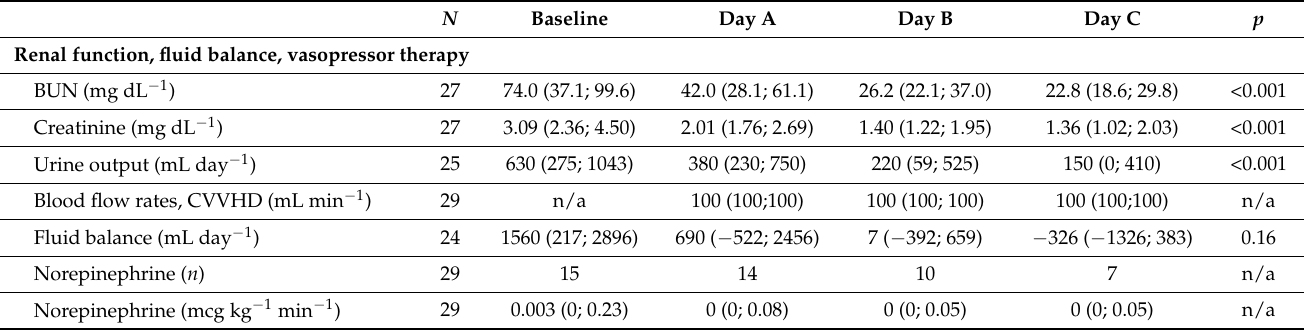
Table 2. Laboratory parameters, procoagulant medication, and blood transfusion